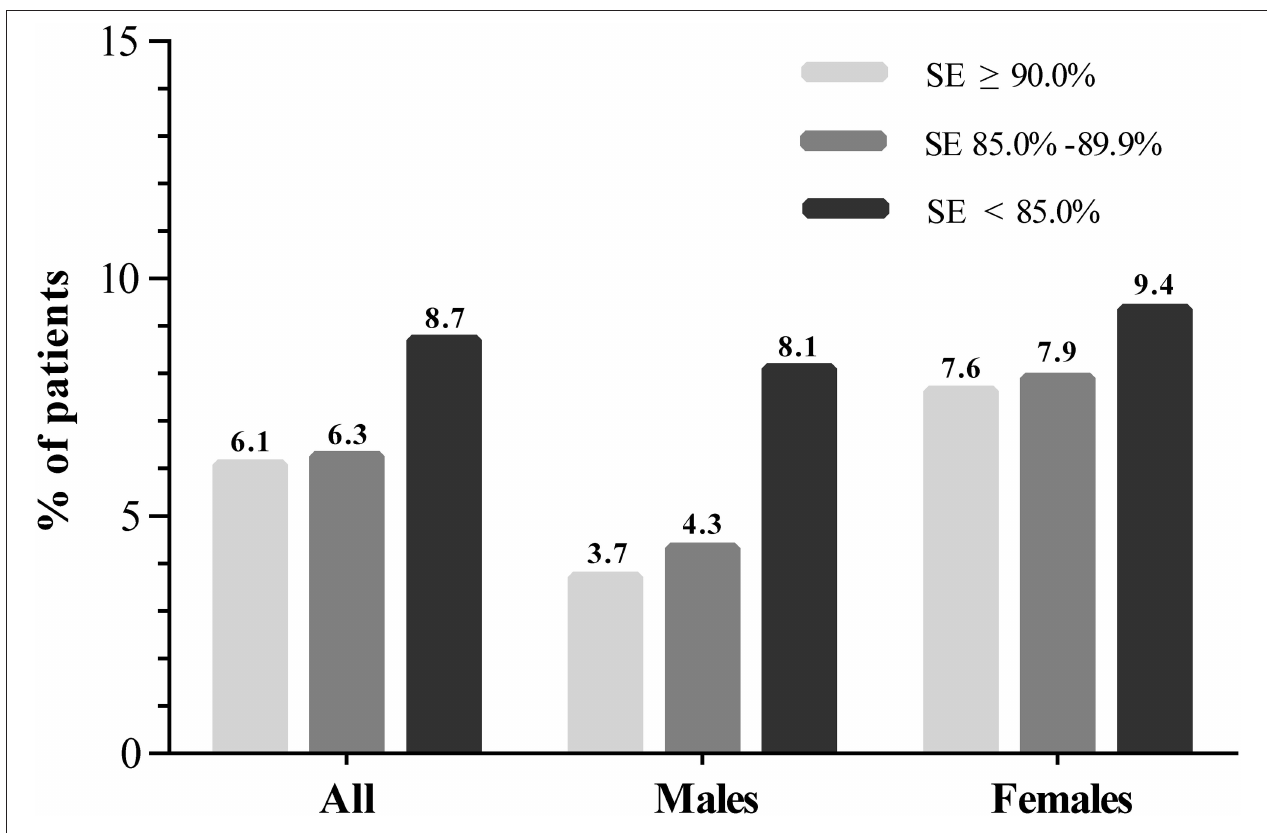
FIGURE 1 | The distribution of incident depression in different SE